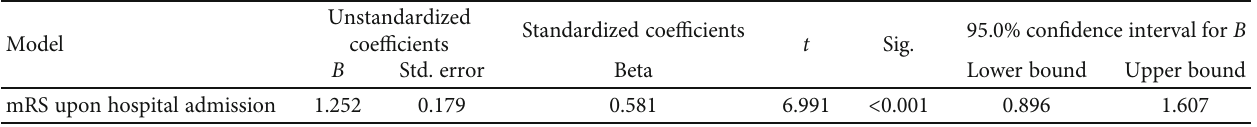
Table 8: Linear regression taking mRS score upon hospital discharge as the dependent variable and the mRS upon hospital admission as the independent